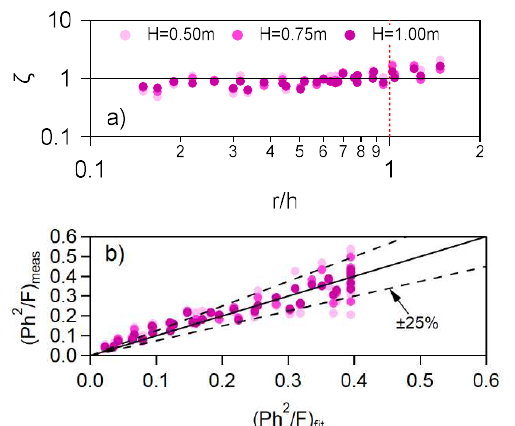
Fig. 6. a) 𝜻 versus 𝒓/𝒉 for different dropping heights. The continuous line is a horizontal fit, whose average is close to 1. The dashed vertical line just splits the graph in the region 𝒓/𝒉 > 1. In b) we show the estimation of the goodness of fit of Eq. 1. The continuous line is a linear fit of slope 1. The dashed lines represent the boundaries of a ±25% scattering